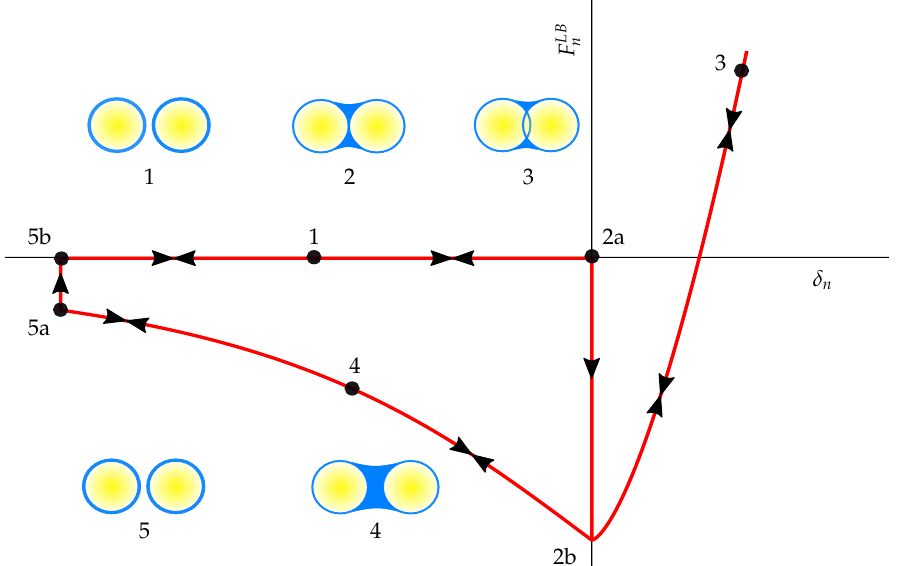
Figure 7. General normal force-displacement law of the liquid-bridge